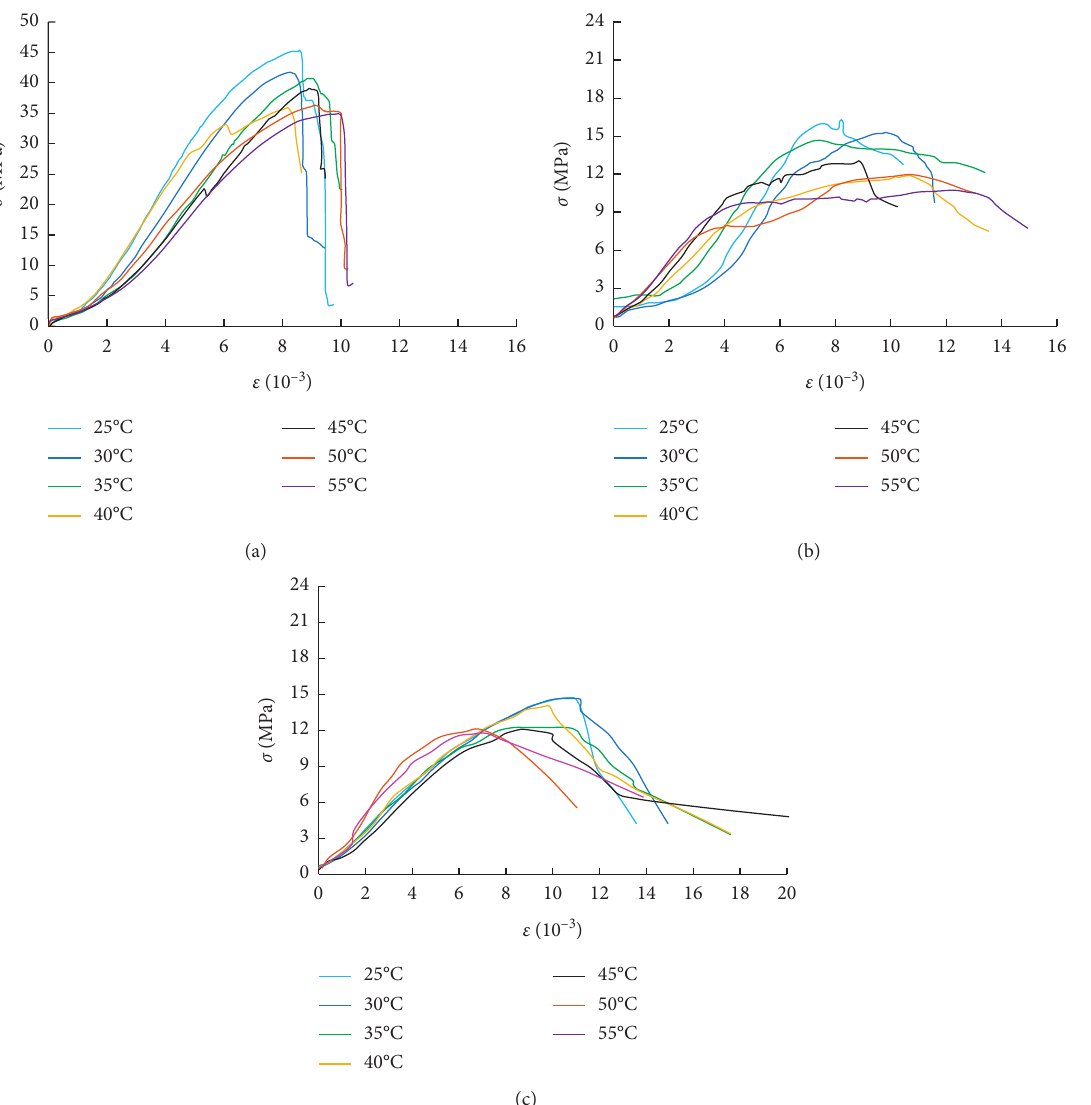
Figure 3: Stress-strain curves of three types of soft rocks at different temperatures. (a) Sandstone. (b) Sandy mudstone. (c)